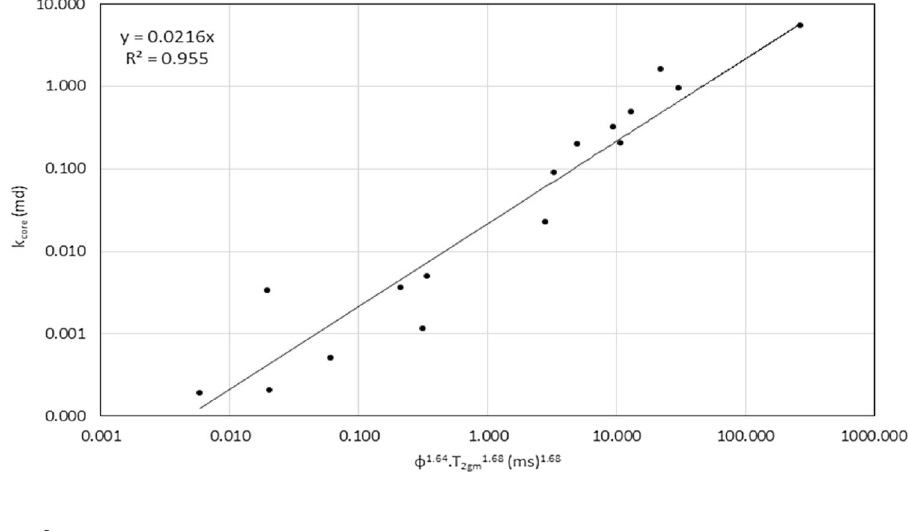
Fig. 14 Correlation of Core permeability and permeability of modified SDR model (design model, m = 1.64, n =